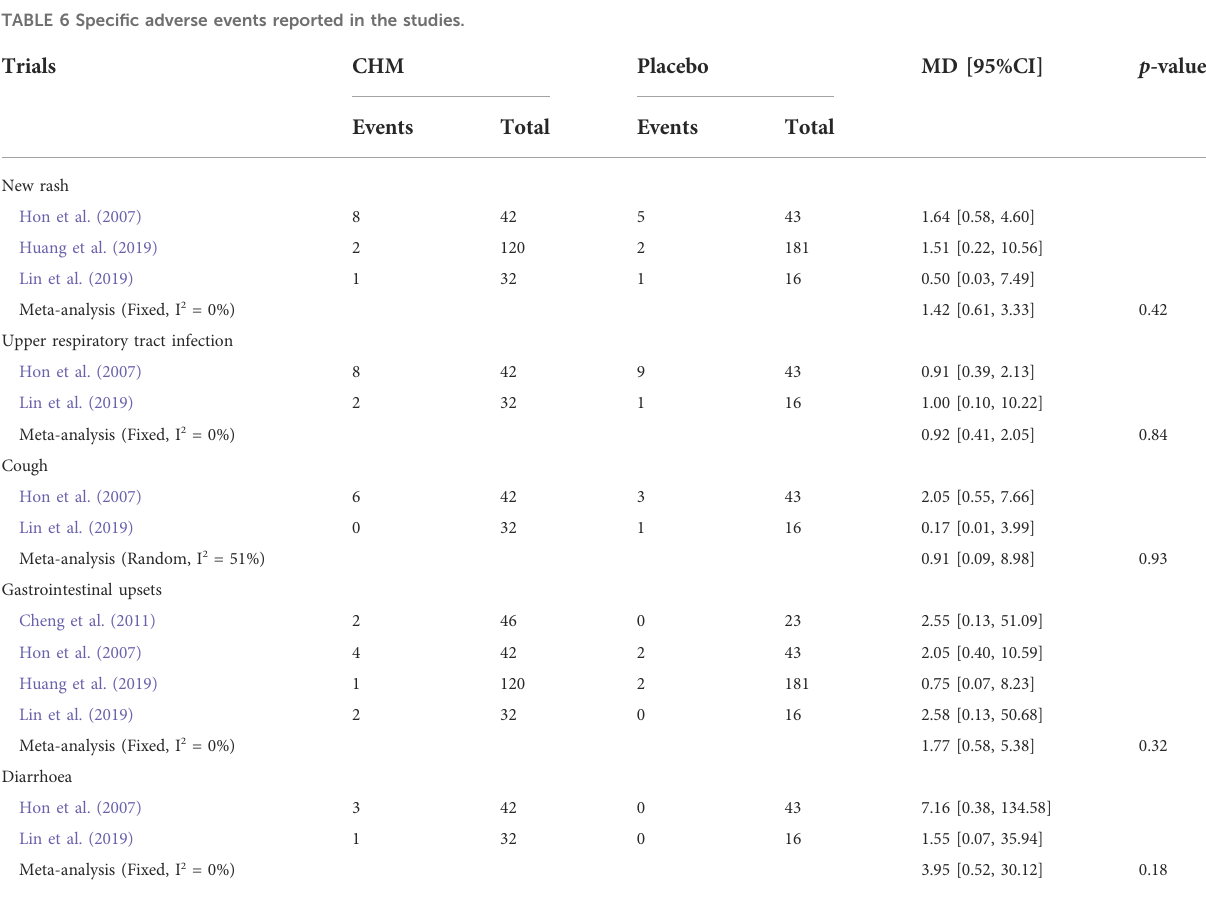
TABLE 6 Speci fi c adverse events reported in the